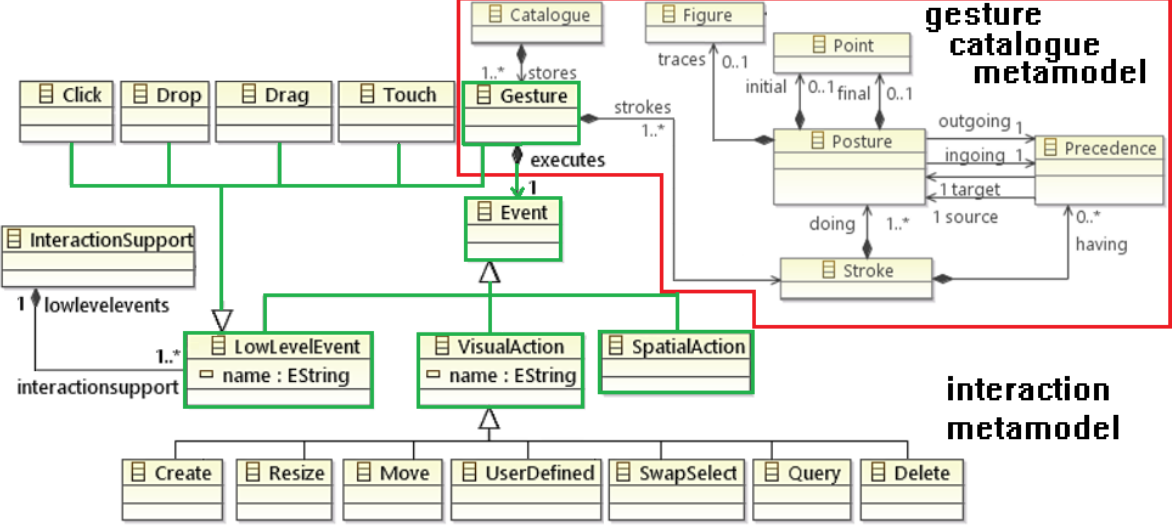
Figure A1.1. Minimum conditions to include gestUI in an interaction model